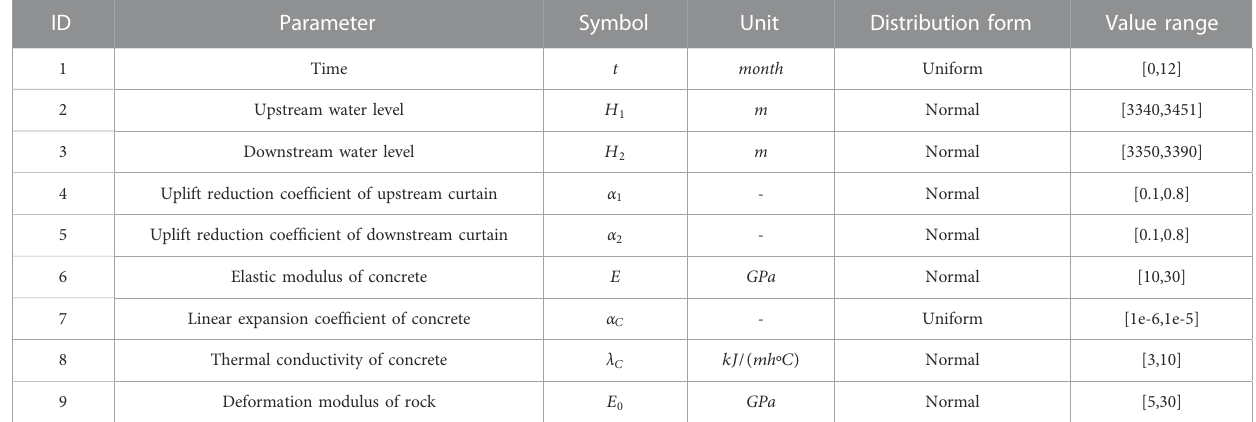
TABLE 1 The probability distribution and value range of the parameters of static behavior surrogate